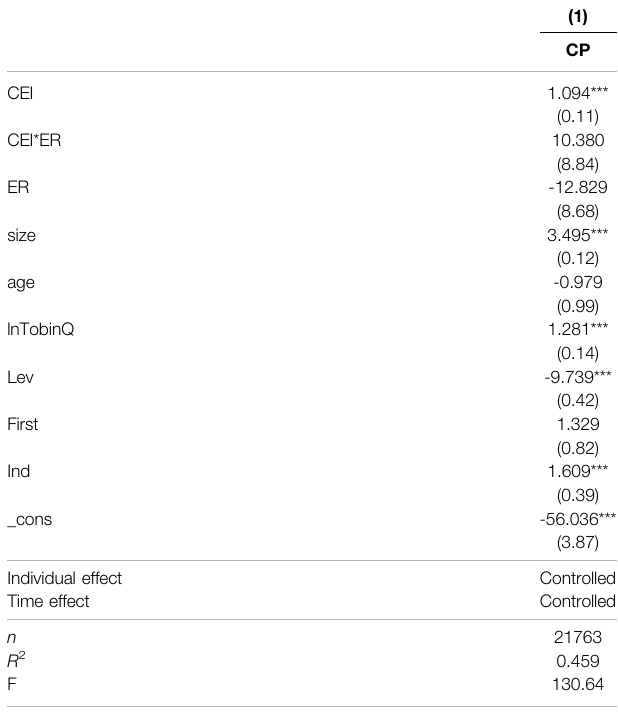
TABLE 12 | Heterogeneity test for regional environmental regulations